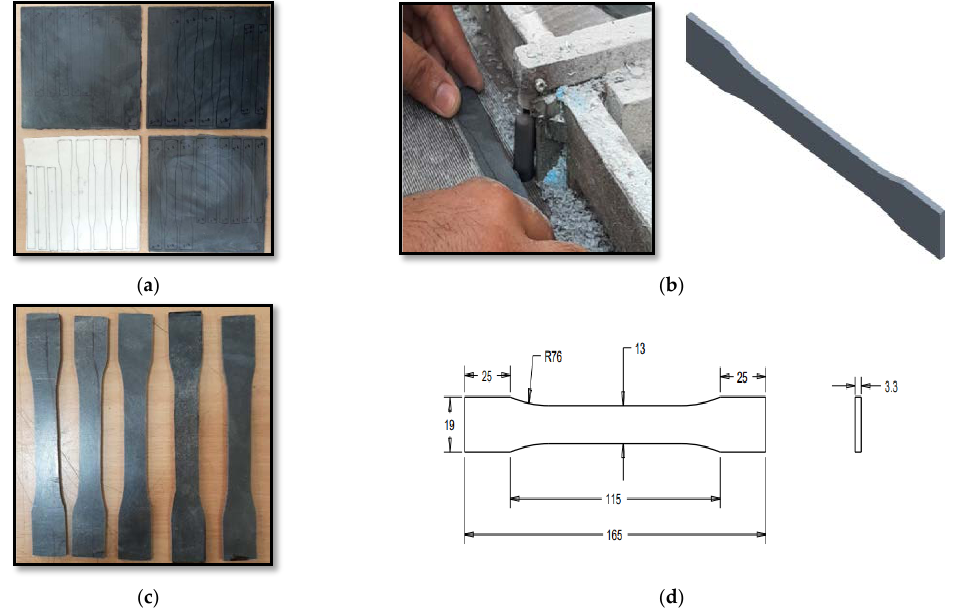
Figure 2. COOH-MWCNT/PMMA specimen preparation: ( a ) sheet generation using compression molding, ( b ) machining process of specimens, ( c ) obtained specimens, ( d ) specimen dimensions.